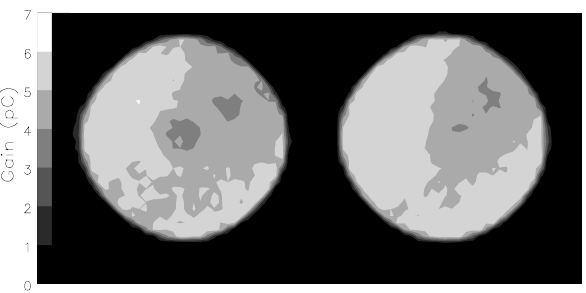
Fig. 8 . Image sequence showing the shift in focus position across the imaging plane produced as the optic is tilted through an angle of 22.3° in 2.23° steps. The distance between adjacent spots is 2.89 ± 0.08 mm. The curved path followed by the spots may be due to local deviations from the spherical figure, and hence correct slump radius, of the MCP (see Fig. 5).